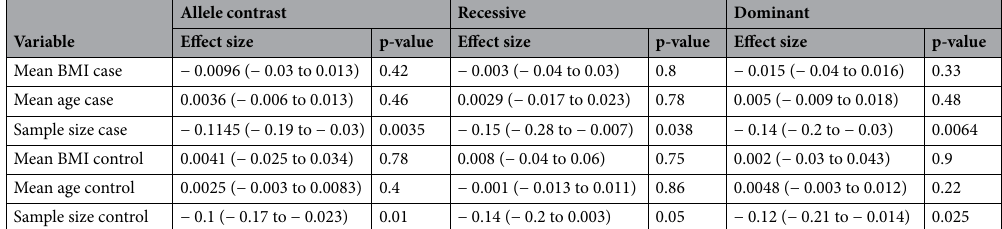
Table 4. Meta-regression results for rs5219. BMI and age are quantitative traits. Sample size was considered a binary trait. Studies with fewer than 1000 samples and those with more than or equal to 1000 samples were categorized as small and large sample sizes,